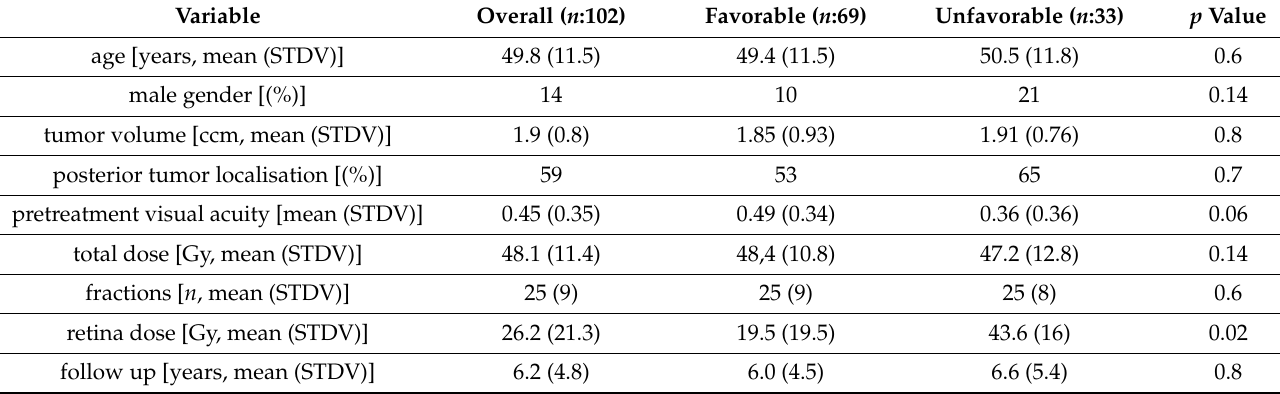
Table 2. Pretreatment epidemiological and clinical variable of the data review, overall and dichotomized (favorable outcome with improvement of the acuity vs. unfavorable outcome with stable or worsening of the acuity), p value of the Mann–Whitney test or Fisher’s exact test between the favorable and unfavorable group.